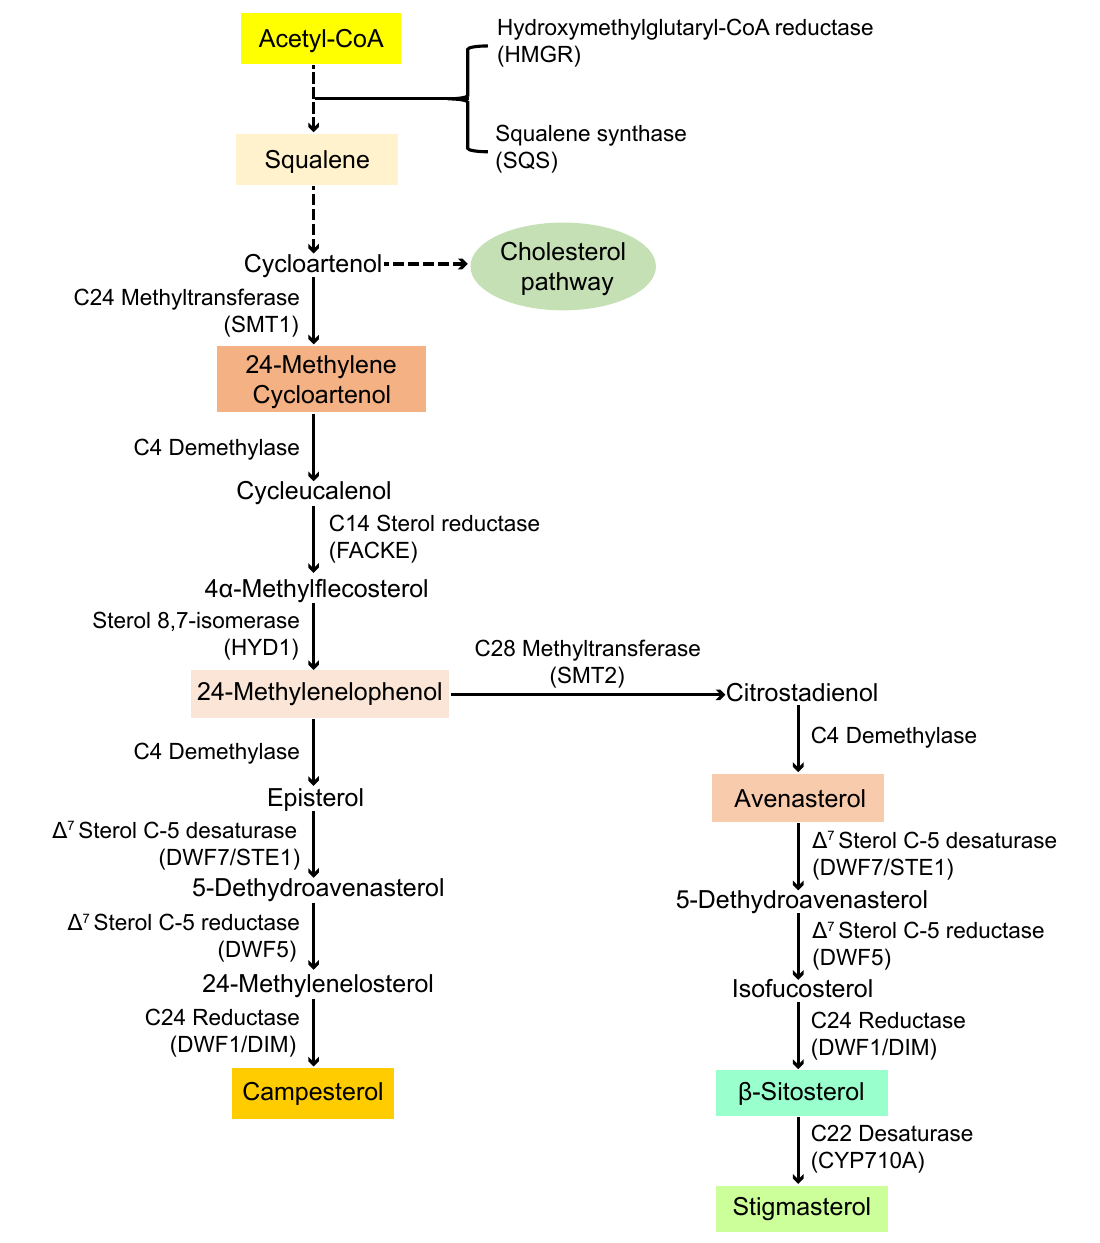
Figure 1. A diagram of the phytosterol biosynthesis pathway in plants. Adapted from